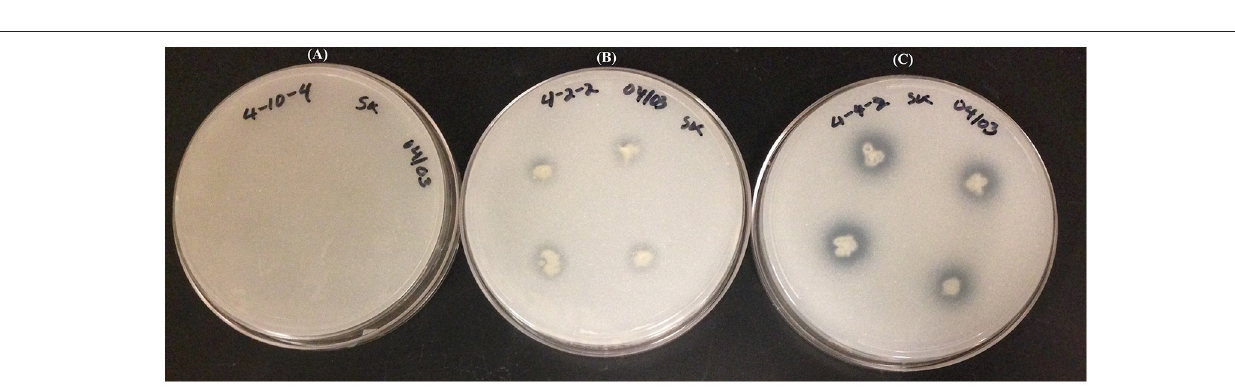
Liquid chromatography-mass spectrometry and nuclear magnetic resonance spectroscopy of poplar endophytes